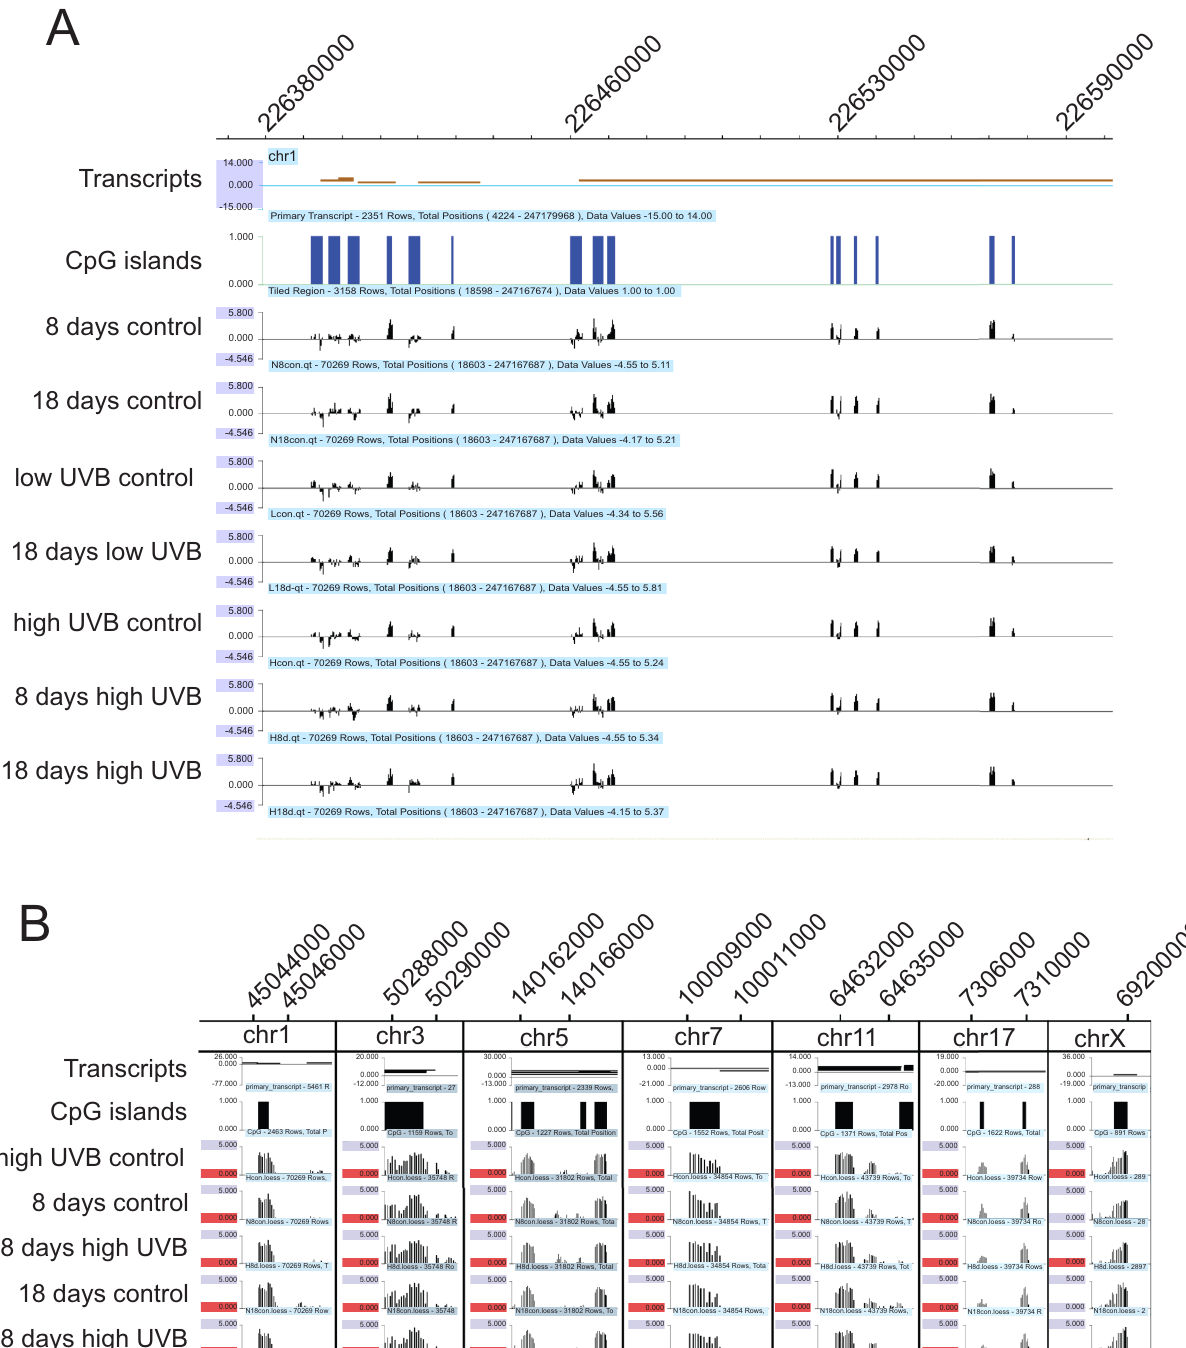
Figure 1. DNA methylation peaks in control and UVB-irradiated keratinocytes. A. A random segment of chromosome 1 is shown to indicate the reliability of the method and to show the uniform peaks between control and UVB-irradiated samples. The positions of transcripts and CpG islands are indicated. The samples labeled ‘low UVB control’ and ‘high UVB control’ represent DNA immediately harvested following a one-time irradiation of cells with either 130 J/m 2 (low) or 260 J/m 2 (high) of UVB. Samples labeled ‘8 days control’ or ‘18 days control’ were grown for the same time periods as the irradiated cells but were never irradiated. Samples labeled ‘18 days low UVB’ or ‘18 days high UVB’ were chronically irradiated with 130 J/m 2 (low) or 260 J/m 2 (high) of UVB followed by an 18 day recovery period. The sample labeled ‘8 days high UVB’ was chronically irradiated with 260 J/m 2 of UVB followed by an 8 day recovery period. B. Methylation peaks are shown for randomly selected genomic regions on chromosomes 1, 3, 5, 7, 11, 17 and X. The positions of transcripts and CpG islands are indicated. The chromosomal coordinates are shown above each